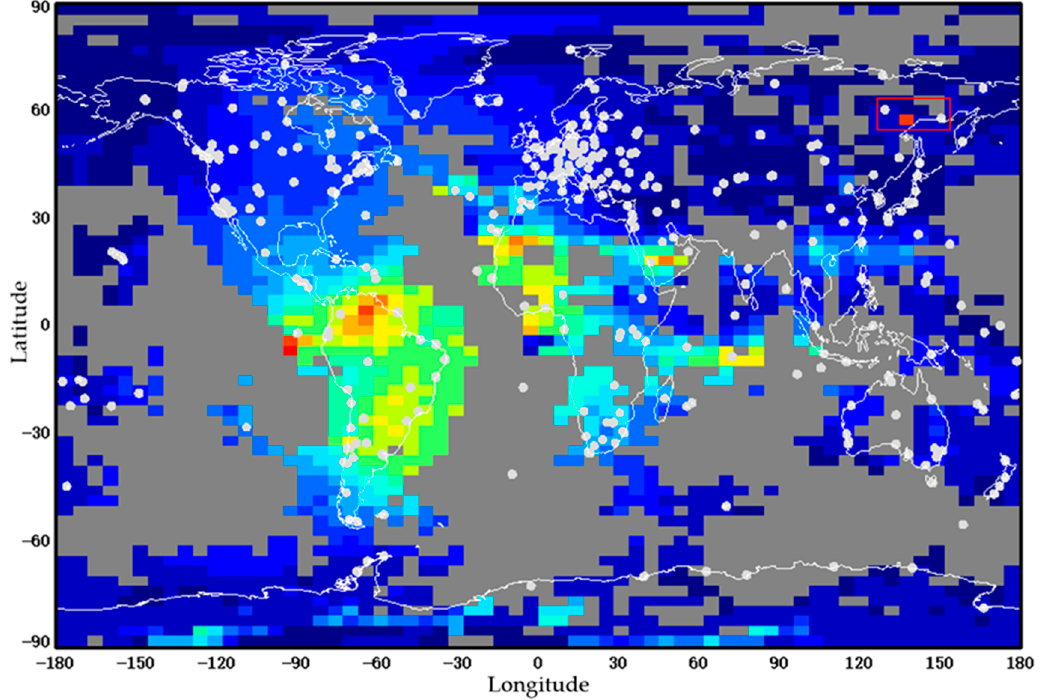
Figure 3. Region of data selection on a TEC (Total Electron Content) map.